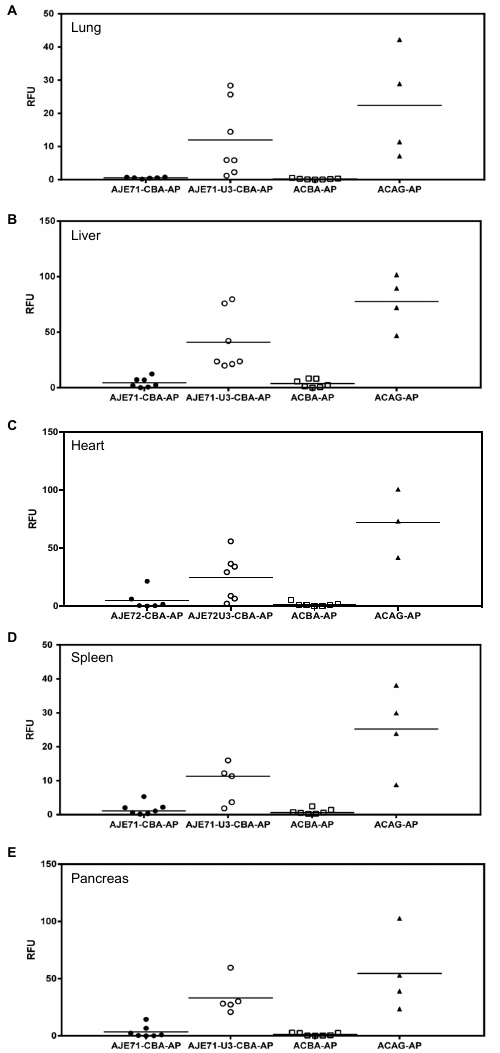
Figure 6. Quantification of alkaline phosphatase activity within homogenized ( A ) lung, ( B ) liver, ( C ) heart, ( D ) spleen and ( E ) pancreas from mice transduced via the intravenous (2 × 10 10 vg), intraperitoneal (8 × 10 10 vg), and intranasal (1 × 10 10 vg) routes with various AAV vectors and harvested for hPLAP enzyme activity analysis 4 weeks post-transduction.